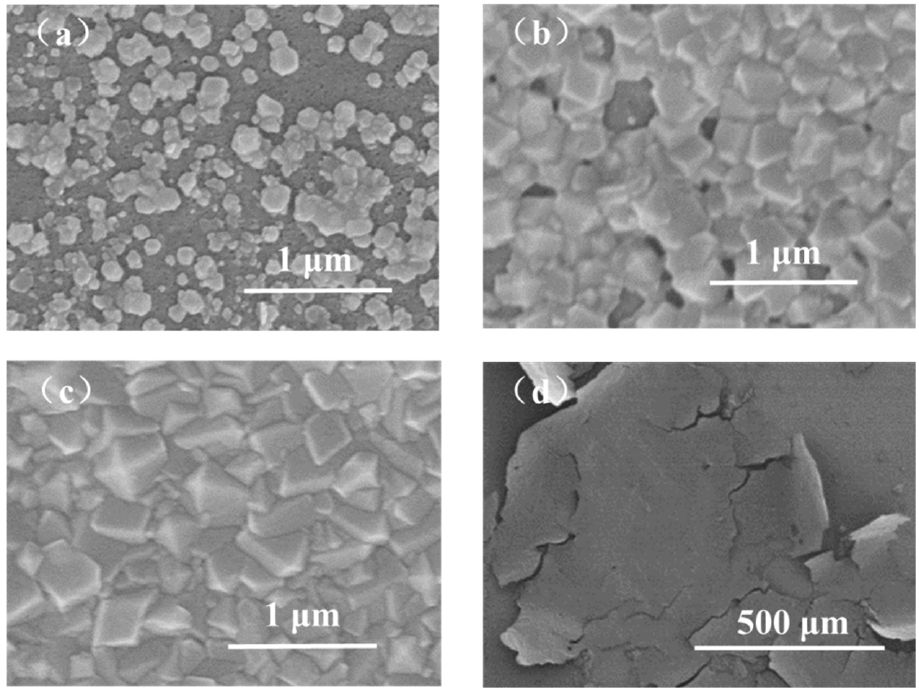
Figure 5. SEM images of ZIF-8/PAN membranes prepared with different deposition times: ( a ) 10 min; ( b ) 40 min; ( c , d ) 60 min (constant voltage: 1 V, molar ratio of zinc ion to 2-methylimidazole: 1:75).